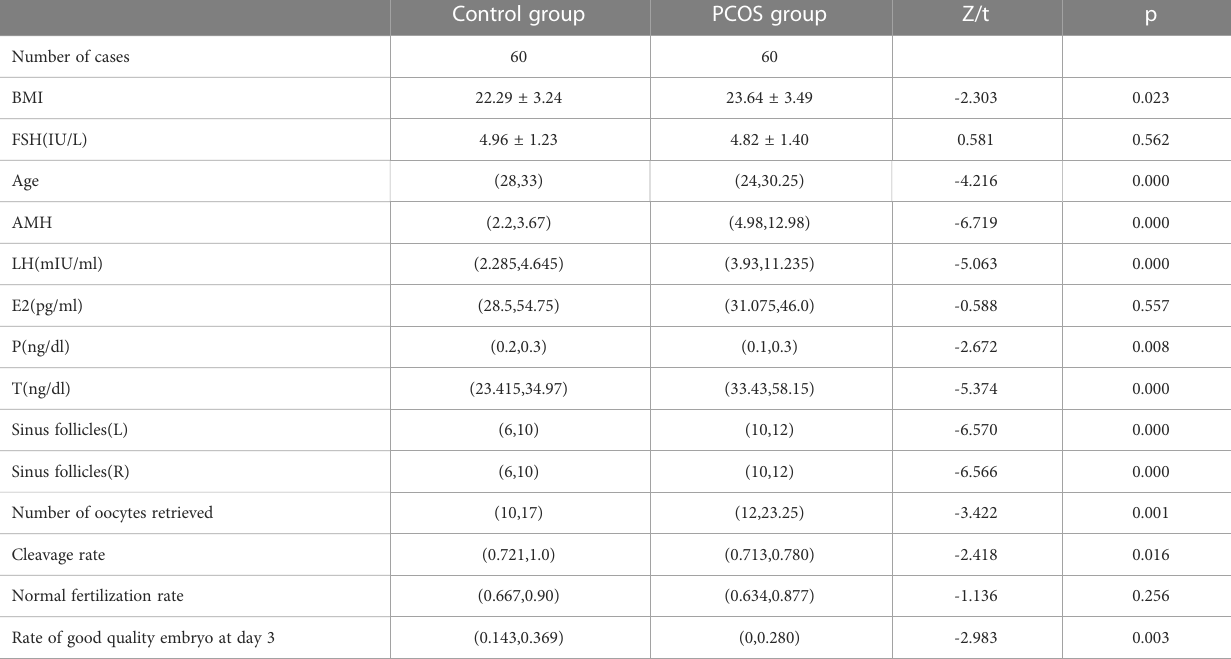
TABLE 2 Clinical data of control group and PCOS group treated with